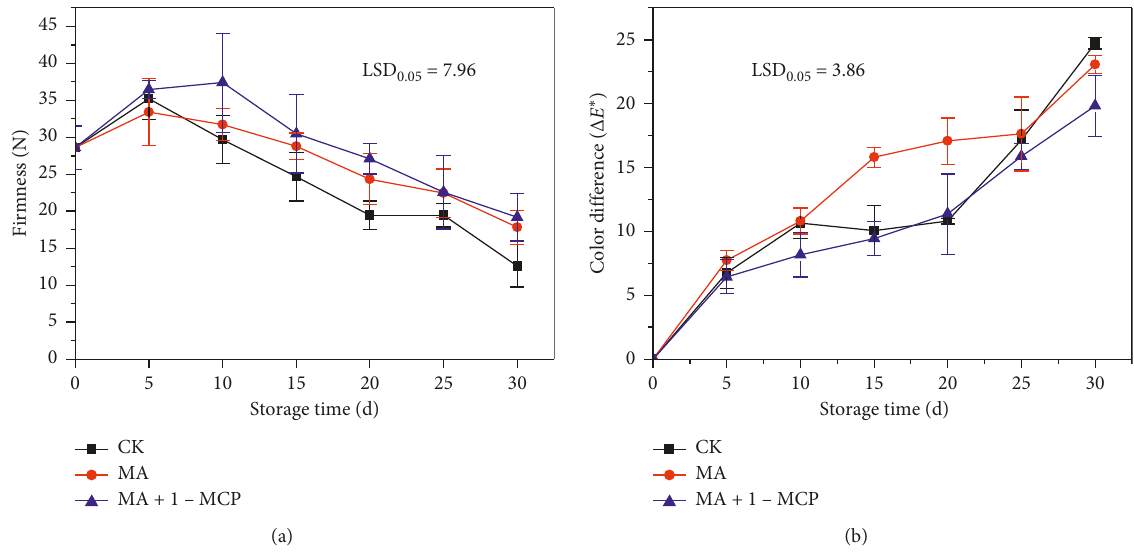
Figure 3: Effects of MA+1-MCP and MA treatment on fruit firmness (a) and color index difference (b) in fig fruit stored at − 1 ° C for 30 days. Data represent the mean value of five measurements ± the standard errors. LSDs represent significant differences at the 0.05